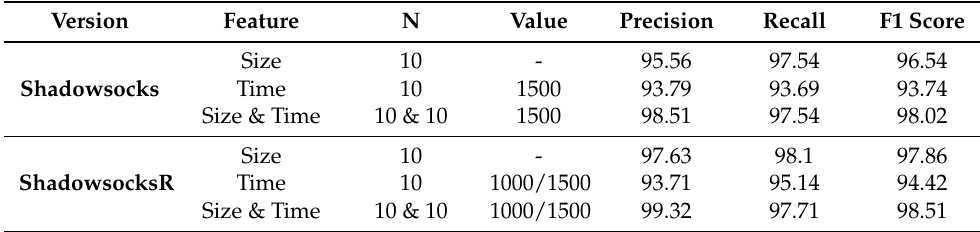
Table 6. The performance of the method on different versions of Shadowsocks traffic detections (%).